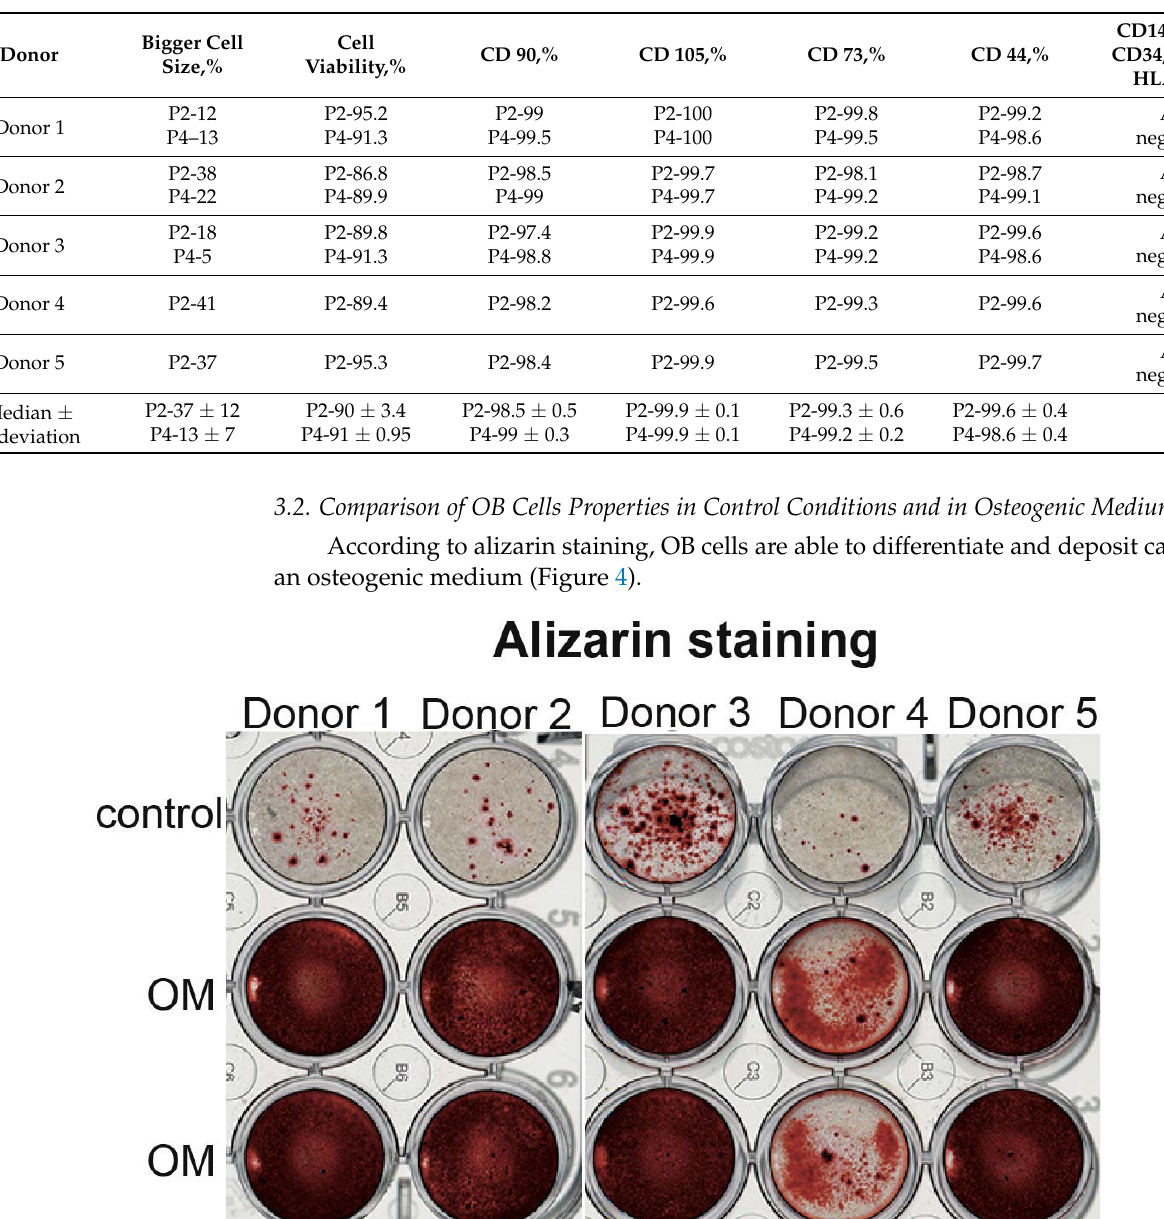
Table 1. Characterization of OB cell size range, cell viability, and surface marker expression by flow cytometry. OB cells are rather heterogenic, have high cell viability, and are positive to mesenchymal cell markers and negative to markers of blood lineage. We have not detected significant changes in the characteristics of OB cells between passages 2–4. P-passage.